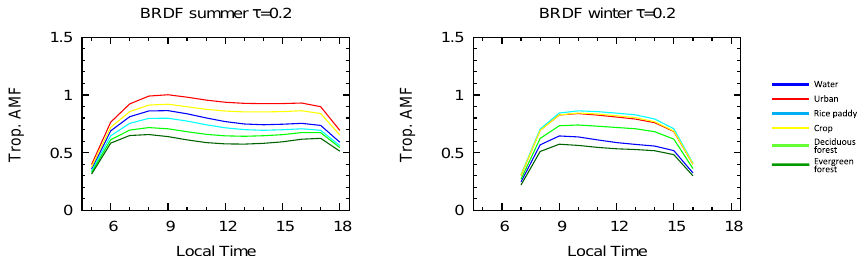
Figure 6. Tropospheric NO 2 AMF in summer (left) and winter (right) using BRDF surface. The colors indicate land cover types: water (blue), urban (red), rice paddy (light blue), crop (yellow), deciduous forest (light green), and evergreen forest (green). For all calculations an aerosol optical depth (AOD) of 0.2 is assumed.